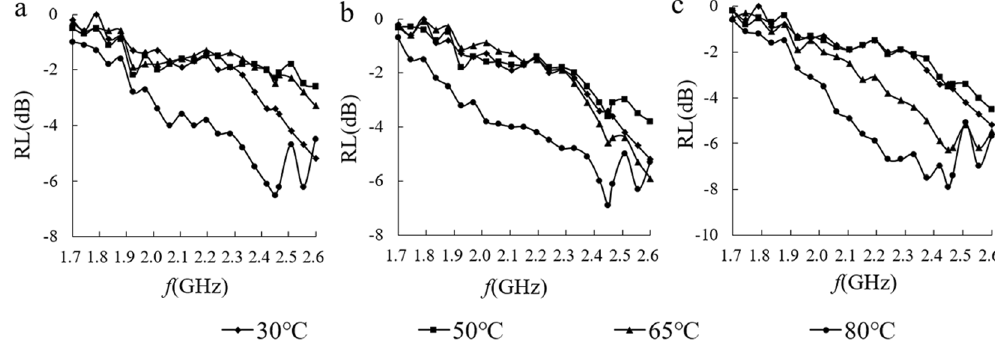
Figure 9. RL curves of starch–water mixtures treated by three heating methods. ( a ) Microwave heating ( b ) Rapid conventional heating ( c ) Conventional heating.